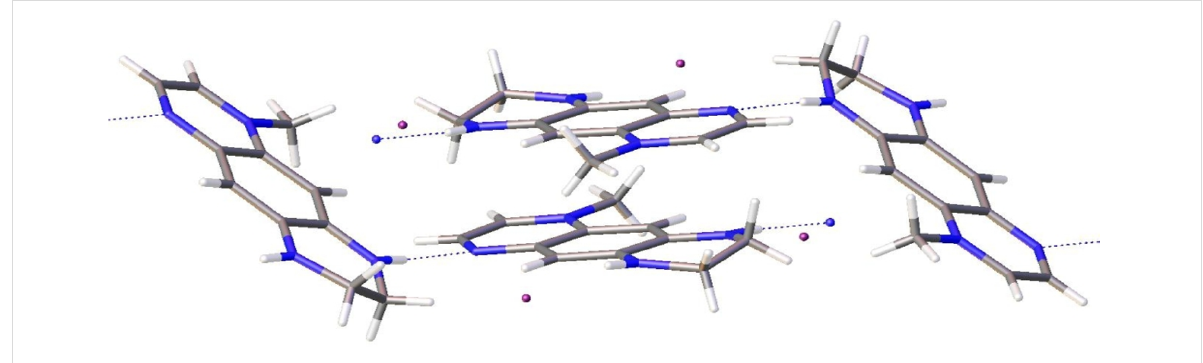
Figure 11: View of the supramolecular array generated by 7a in the solid state. Color coding: nitrogen, blue; carbon, grey; iodine, violet.